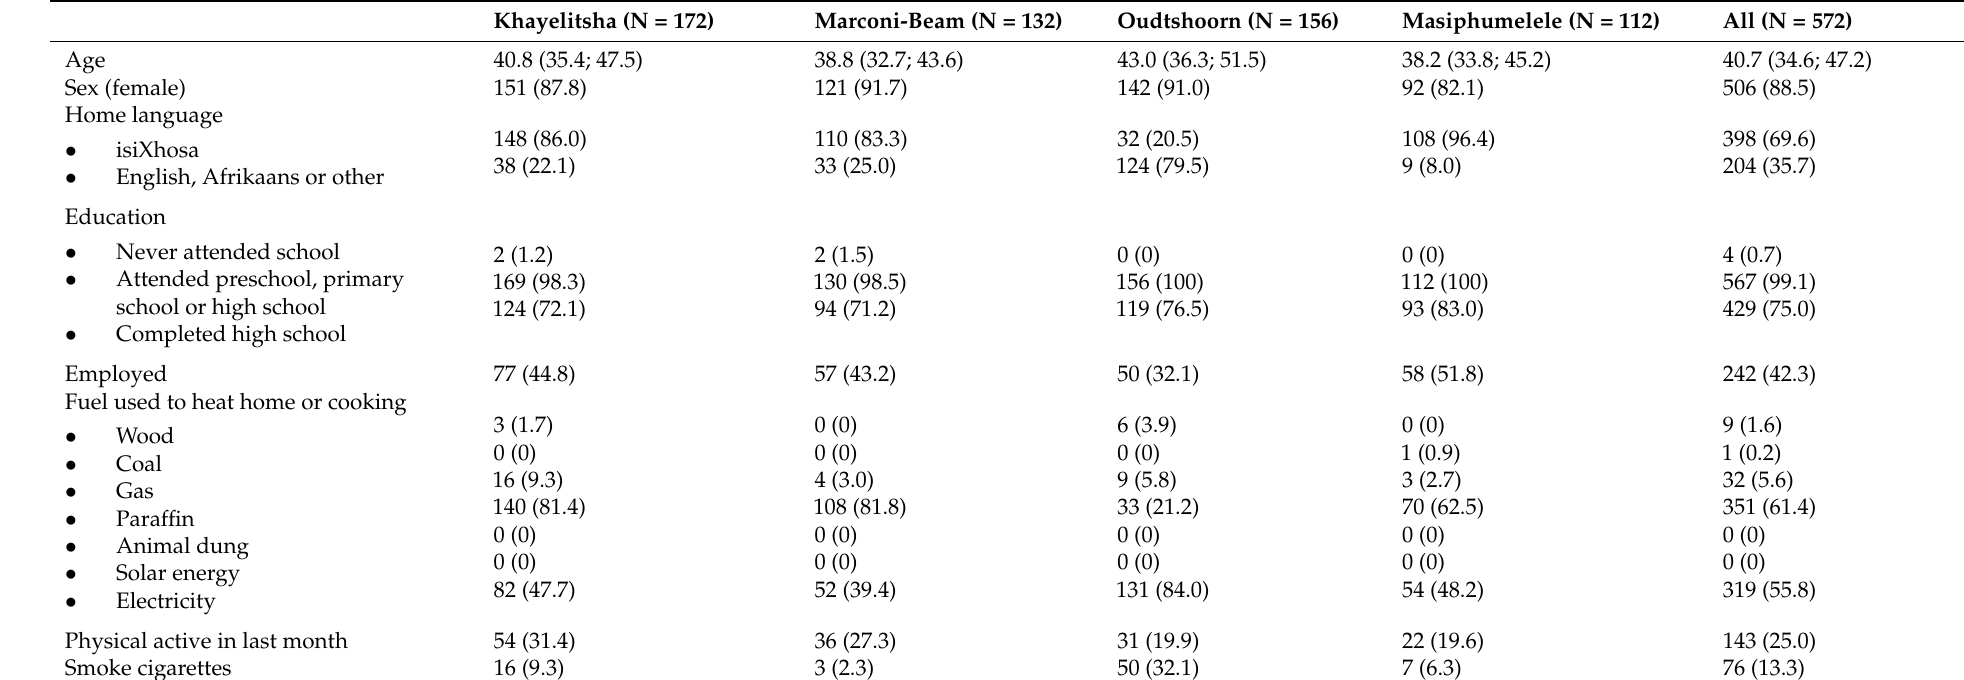
Table 2. Demographics and selected characteristics of the study participants across the four study